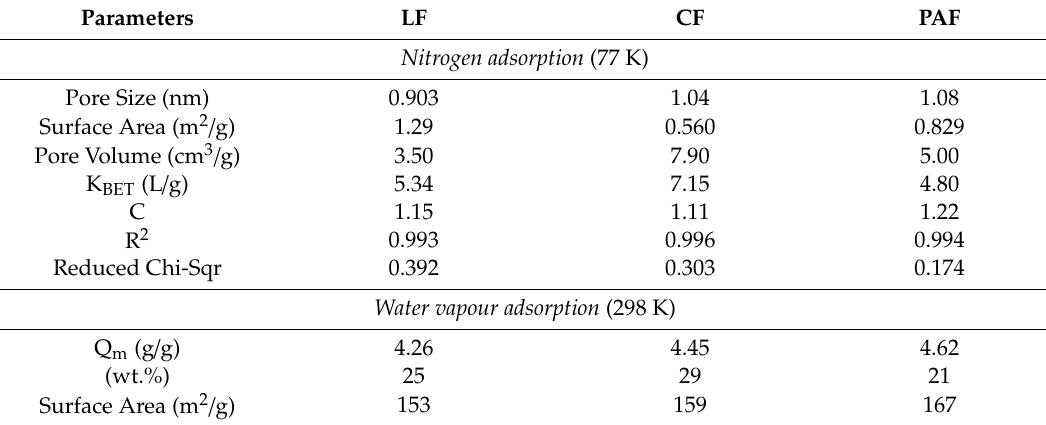
Table 3. Surface and textural properties parameters using BET analysis of the nitrogen adsorption isotherms and water vapour adsorption of linen fiber (LF) and its treated forms (CF,